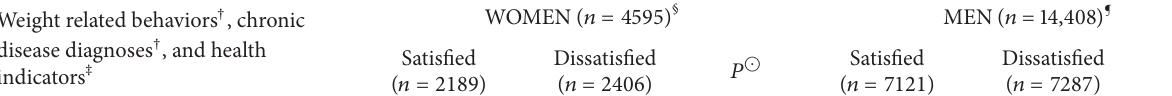
Table 2: Relationships between body weight satisfaction ∗ and weight-related health behaviors, health indicators, and chronic disease diagnoses among women ( 𝑛 = 4595 ) and men ( 𝑛 = 14, 408 ) in the Aerobics Center Longitudinal Study,